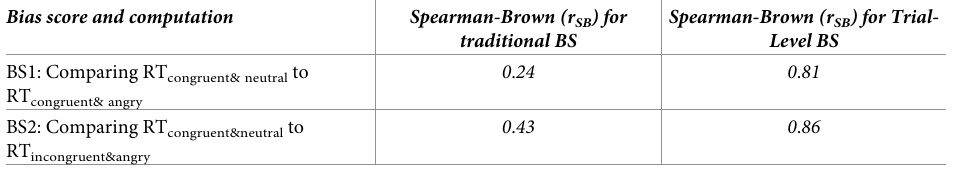
Table 1. Bias scores: Computation and